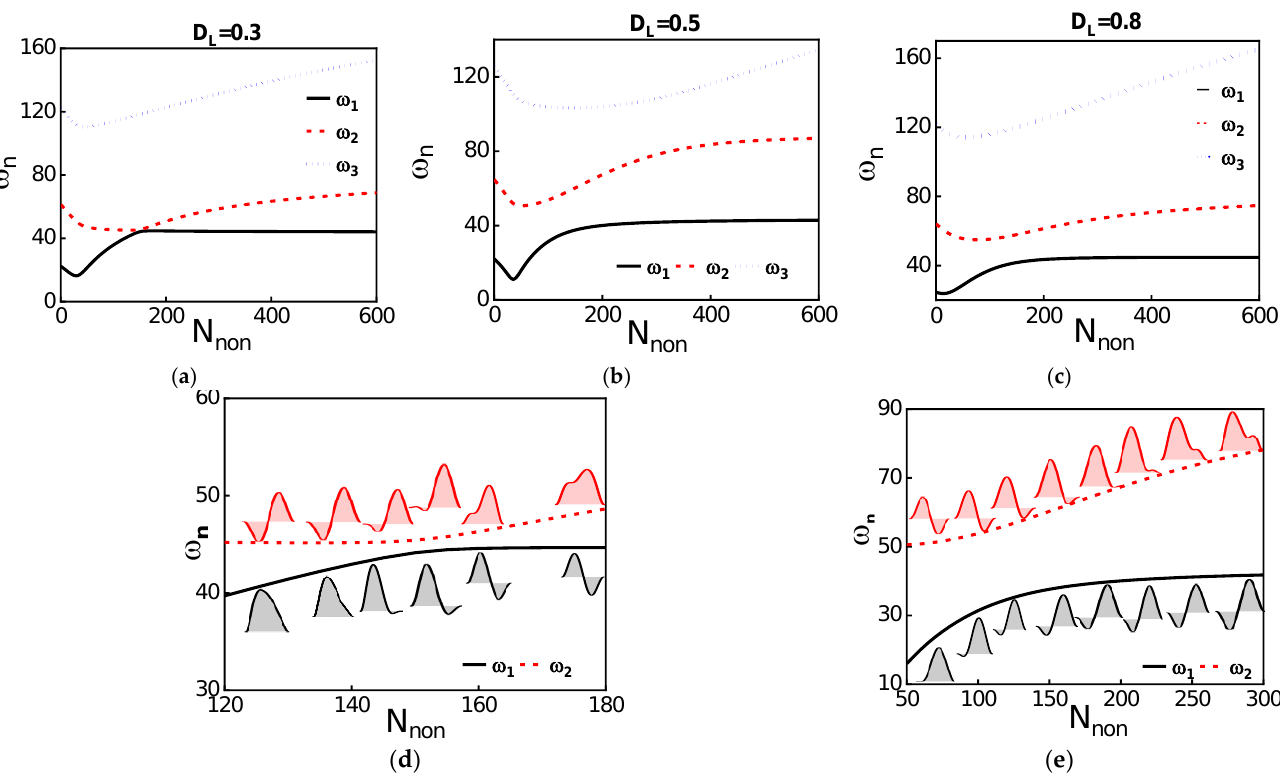
Figure 6. ( a – c ): The variation of the three lowest natural frequencies with axial load for different dome lengths, D L = 0.3, D L = 0.5, and D L = 0.8, respectively. The initial rise of the dome is equal to 1 µm. ( d , e ) show a zoomed view of the avoided crossing zone between the first two lowest frequencies for D L = 0.3 and D L = 0.5, respectively. The insets of ( d , e ) are the associated modes shapes of the first two lowest frequencies at different axial load values.